Question: According to the figure, is the described quantity increasing or decreasing?
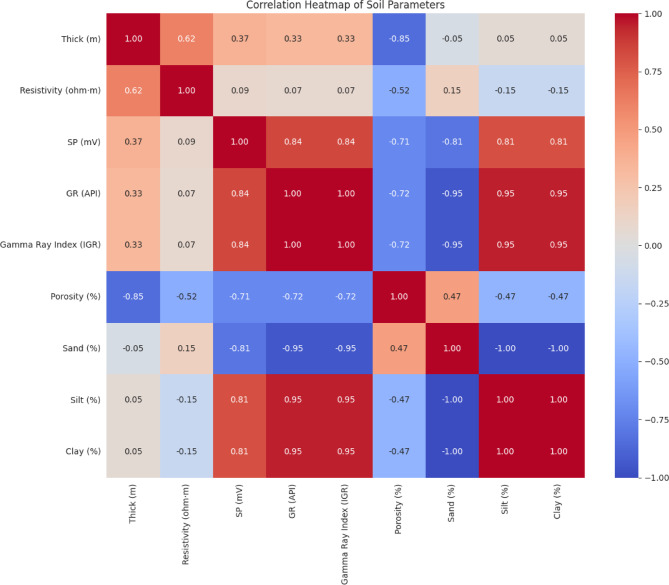
Answer: decreasing